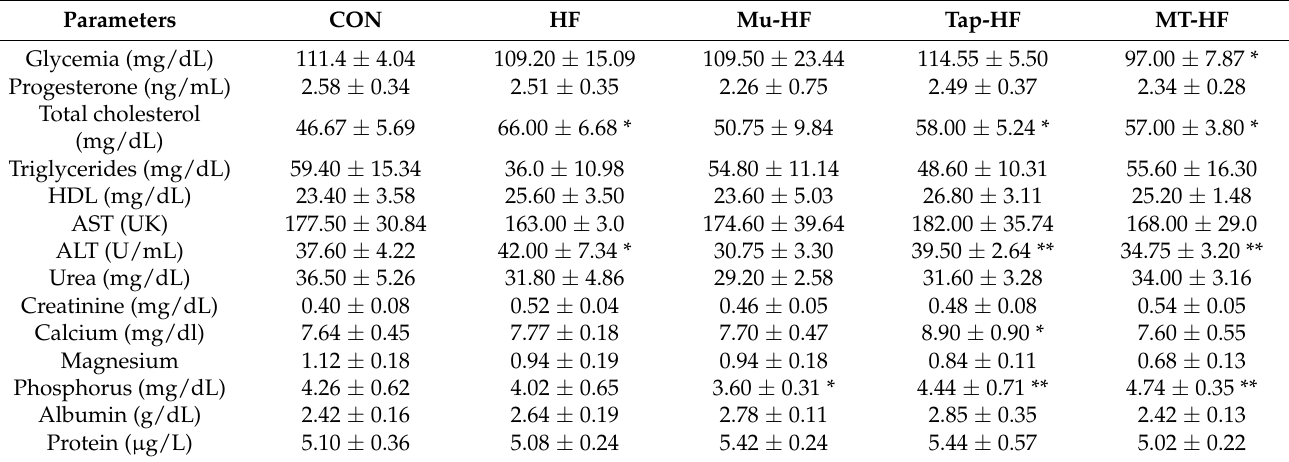
Table 3. Metabolic variable in rats fed with experimental diets.